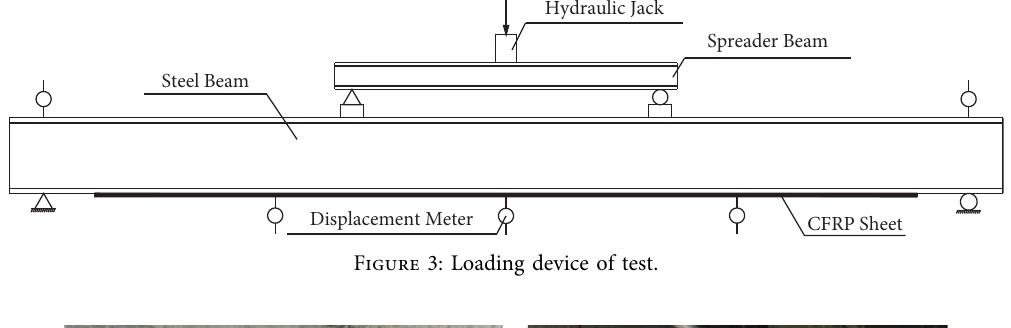
Figure 3: Loading device of test.